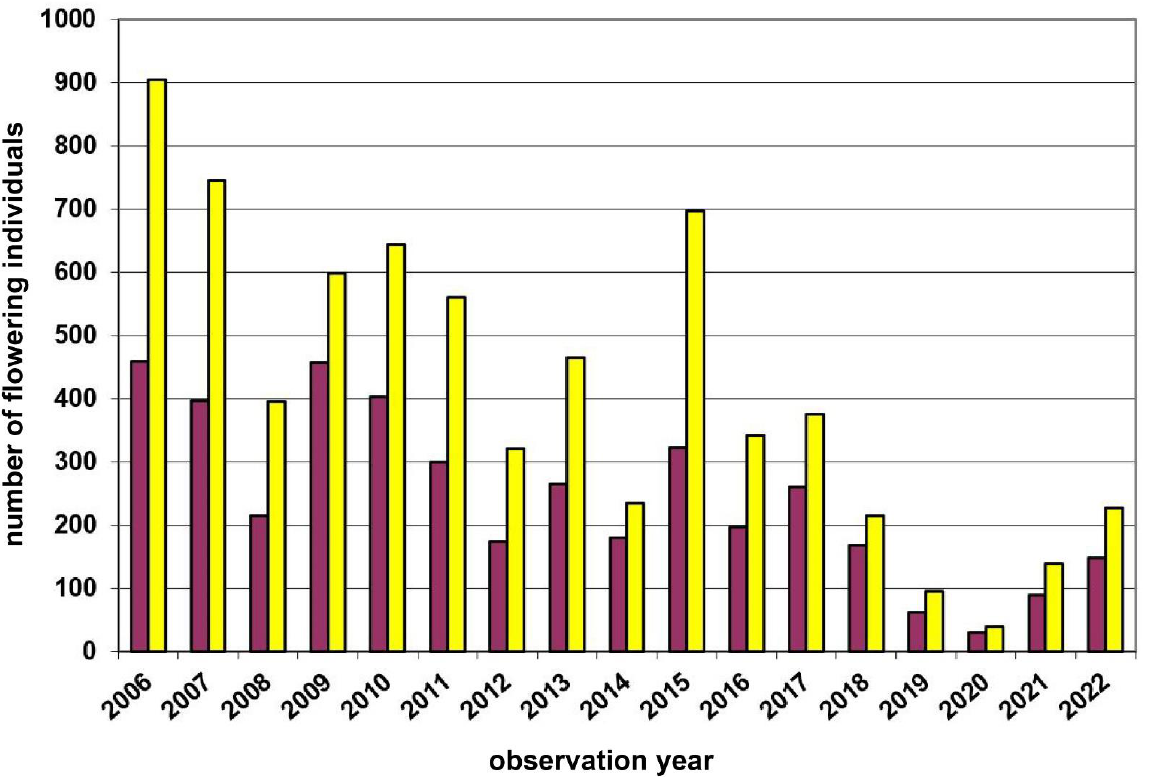
Figure 3. Population census (2006 – 2022) of the Dactylorhiza sambucina -population Voitsau I in the Waldviertel region. Red columns = red-flowering plants and yellow columns = yellow-flowering plants.